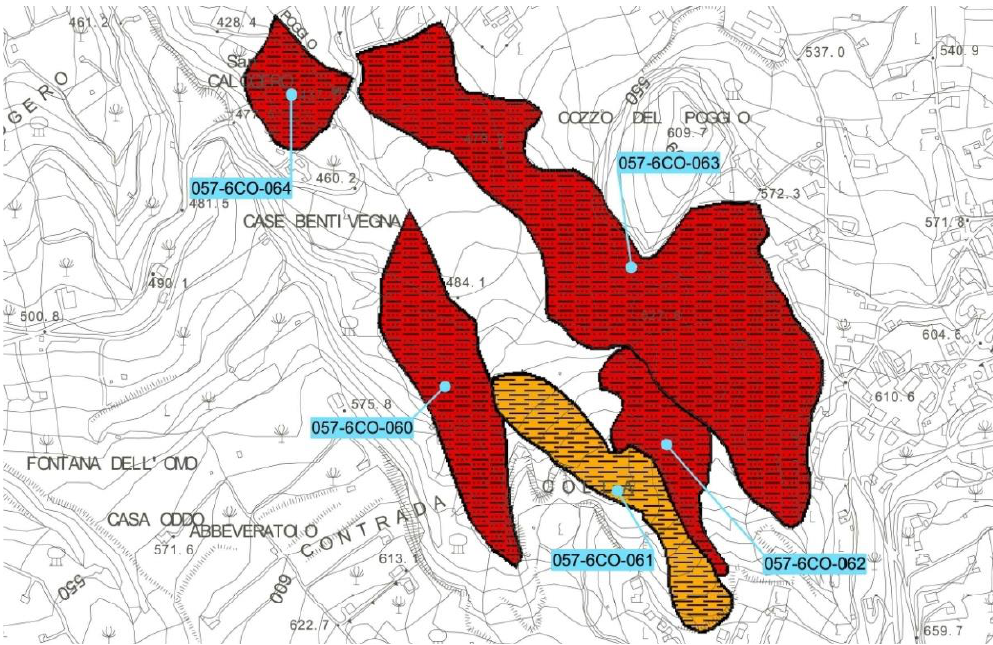
Figure 1. - Hydrographic basin of Belice river (057) - excerpt of the Map of Instability n. 19, including the surveyed area (Sicilian Region - Territory and Environment Department, Basin Shred Plan for Hydrogeological Layout, 2005): the areas where soil erosion caused landslides are highlighted, i.e. those having active landslides are in red colour, while those having landslides at rest are in yellow colour.